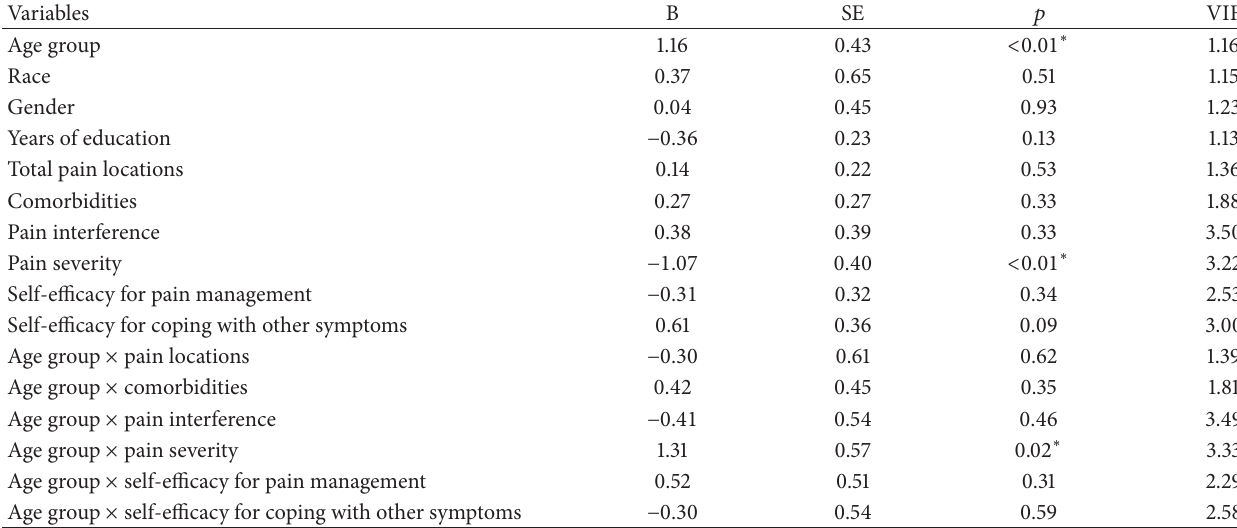
Table 2: Predictors of patient satisfaction with pain management (final model).